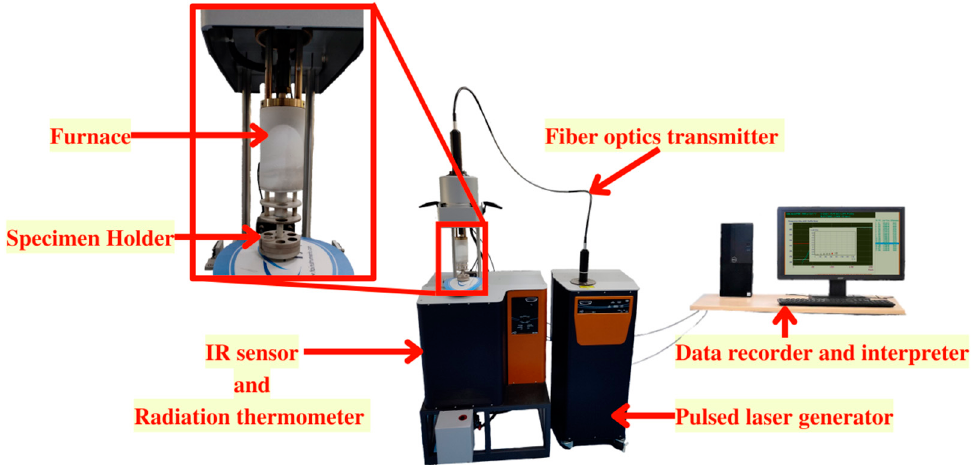
Figure 5. LASER flash thermal analysis system.